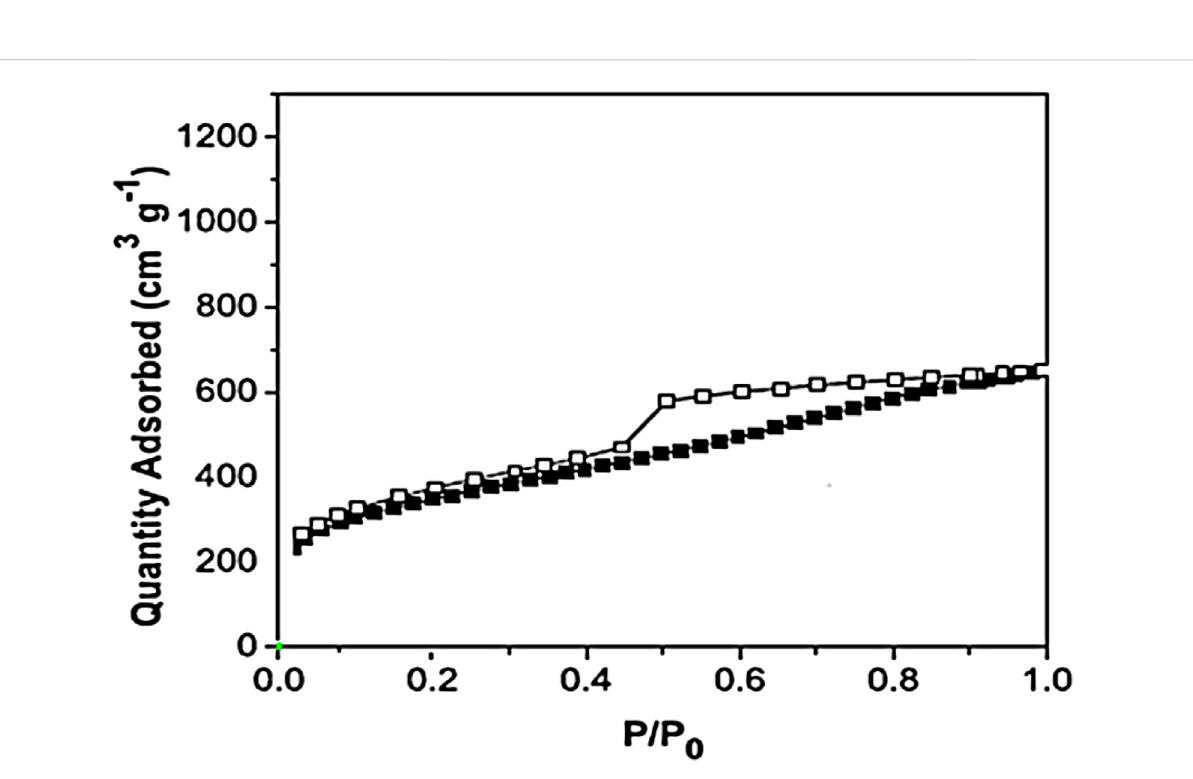
FIGURE 3 N 2 adsorption/desorption of CCPSF